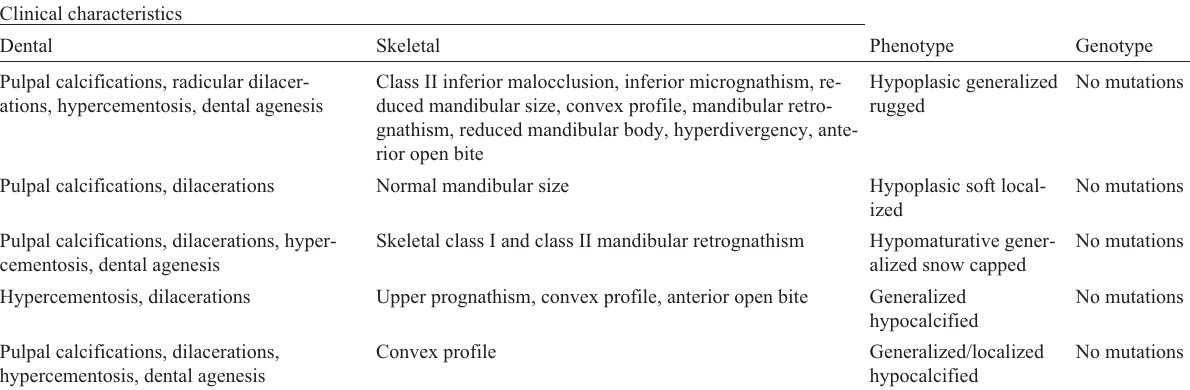
Figure 1 - Family 1. A. The pedigree indicated autosomal dominant inher- itancewitheightaffectedmembers(blacksymbols).Theasterisksindicate individuals who were analyzed clinically and whose ENAM gene was se- quenced.Someindividualsshowedopenanteriorbite.Thearrowindicates the proband III:3 patient. B. Photograph of proband III:3. The phenotype of this family was classified as generalized, rugged and severely hypo- plasic with horizontal grooves. Many teeth showed caries and crown de- struction while others were in the final stages of preparation for a pros- thetic implant. C,D. Periapical and panorex radiographs of the same proband showing most of the teeth. Note the large areas of radiolucid enamel and the absence of several teeth. Table 5 - Summary of the dental and skeletal anomalies, phenotypes and genotypes encountered in affected individuals belonging to the five families with ADAI. Clinical